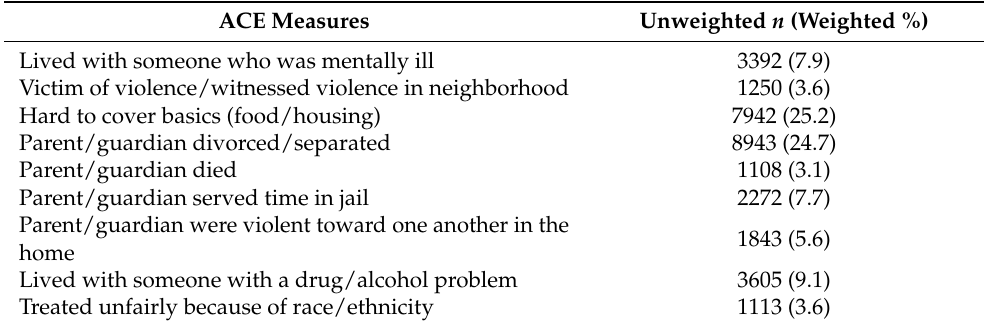
Table 2. Distribution of Adverse Childhood Experiences, National Survey of Children’s Health